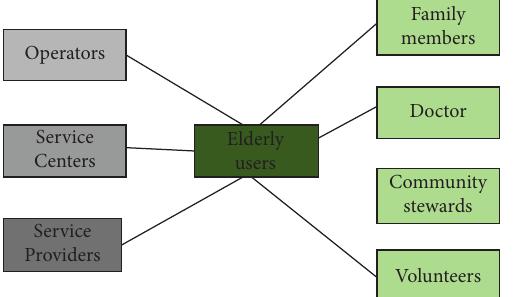
Figure 3: Composition of relevant players and institutions in “Internet+” applications.